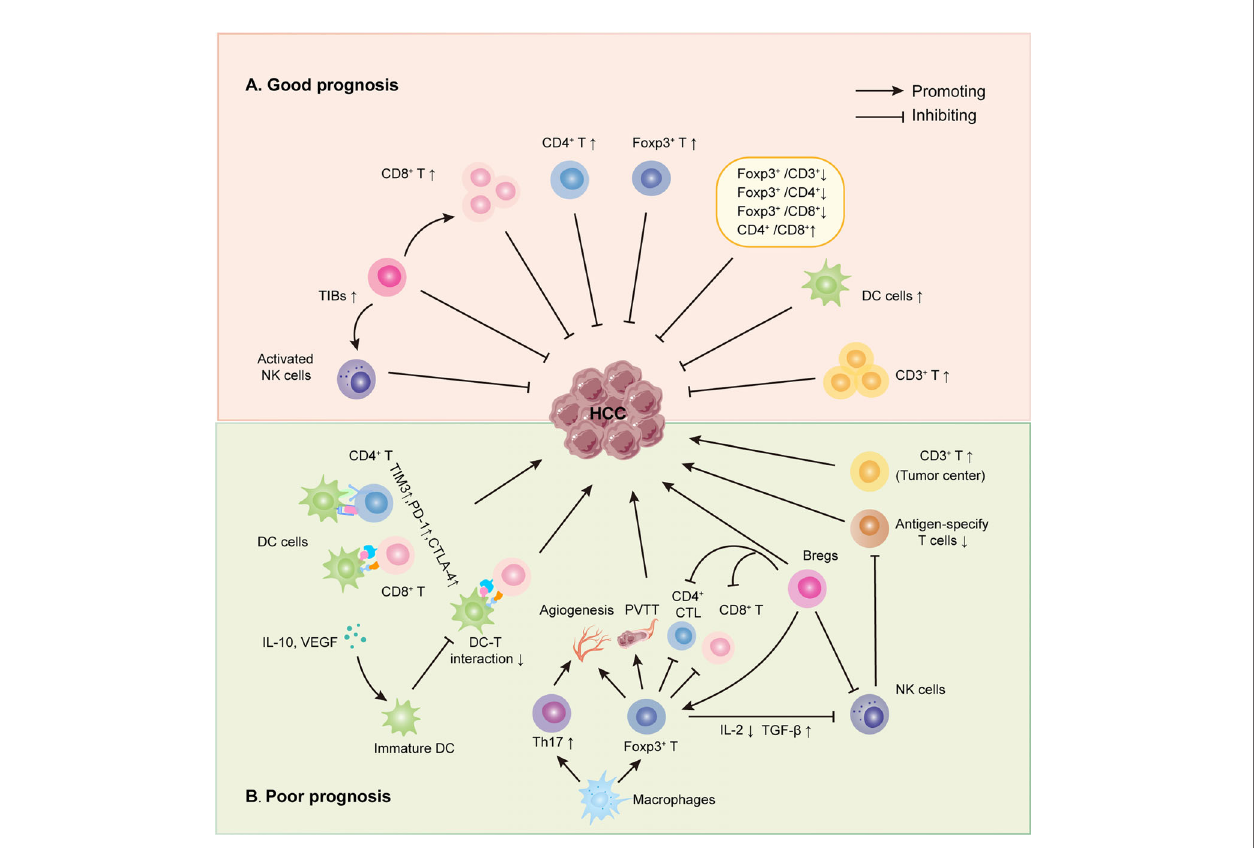
FIGURE 1 | Roles of in fi ltrating immune cells in HCC. (A) The suppressing role of TILs on HCC. Initially, several in fi ltrating T lymphocytes, including CD3+, CD8+, activated NKs and Foxp3+ TILs, have been discovered to inhibit HCC directly. Secondly, some TILs could interact with other immune cells to suppress HCC, such as TIBs prohibited HCC by increasing CD8+ T cells and activating NK cells. Last, different TIL ratios also were proved to hinder HCC progress, just as low Foxp3 +/CD3+ TIL ratio, high CD4+/CD8+ TIL ratio, et al. (B) The promoting role of TILs on HCC. Some in fi ltrating T lymphocytes have been shown to promote HCC directly, like Foxp3+, CD3+ TILs. Also, in fi ltrating T lymphocytes could interact with other immune cells to boost HCC progress via many mechanisms, including reduced DC-T interaction, weakening the function of CD4+ and CD8+ TILs et